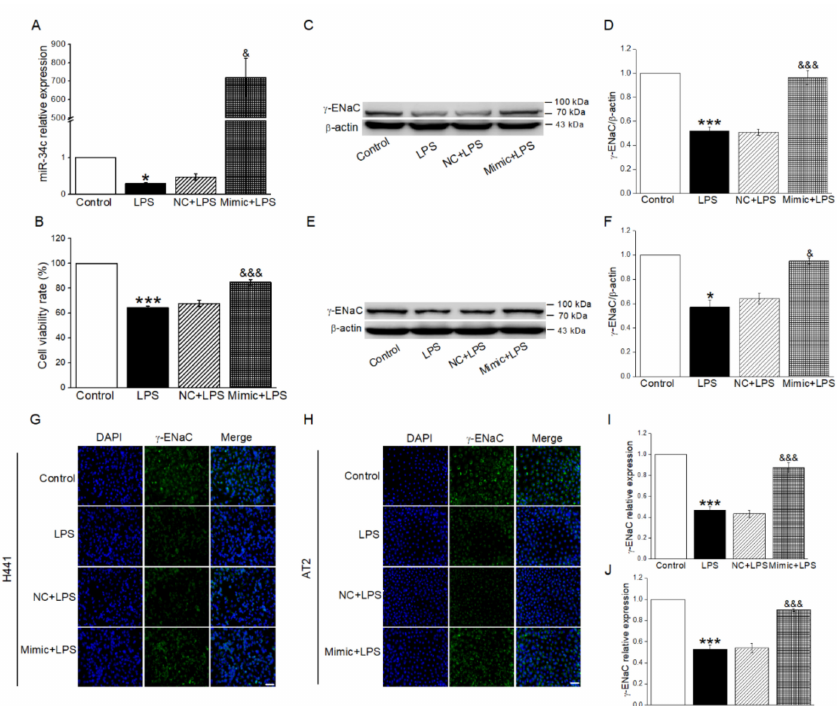
Figure 2. MiR-34c upregulated LPS-inhibited γ -ENaC protein expression in H441 and AT2 cells. ( A ) MiR-34c relative expression level by qRT-PCR assay in H441 cells treated with LPS for 24 h after the transfection with negative control (NC) or miR-34c mimic (Mimic) for 48 h. The normal medium (Control), LPS (10 µ g/mL, 24 h, LPS), NC plus LPS (48 h, NC + LPS) and Mimic plus LPS (48 h, Mimic + LPS) group were performed in H441 cells. The relative level of miR-34c was calculated as miR-34c/U6 ratios ( n = 4). ( B ) MiR-34c enhanced the cell viability in LPS-treated H441 cells by CCK-8 cell viability assay ( n = 4). ( C , E ) Representative blots of γ -ENaC protein in Control, LPS, NC + LPS, and Mimic + LPS group in H441 and mouse AT2 cells, respectively. ( D , F ) Graphical representation of data obtained from Western blot and quantified through gray analysis ( γ -ENaC/ β -actin) ( n = 4). ( G , H ) Immunofluorescent detection of γ -ENaC protein in H441 cells and AT2 cells. Nuclei were counterstained by 4,6-diamidino-2-phenylindole (DAPI, blue; left panel) and γ -ENaC (green; middle panel). The merged images are seen (right panel). Scale bar = 50 µ m. ( I , J ) Graphical representation of data obtained from immunofluorescent detection and quantified through gray analysis in H441 cells and AT2 cells ( n = 4). Note: * p < 0.05, *** p < 0.001, compared with Control group; & p < 0.05, &&& p < 0.001, compared with NC + LPS